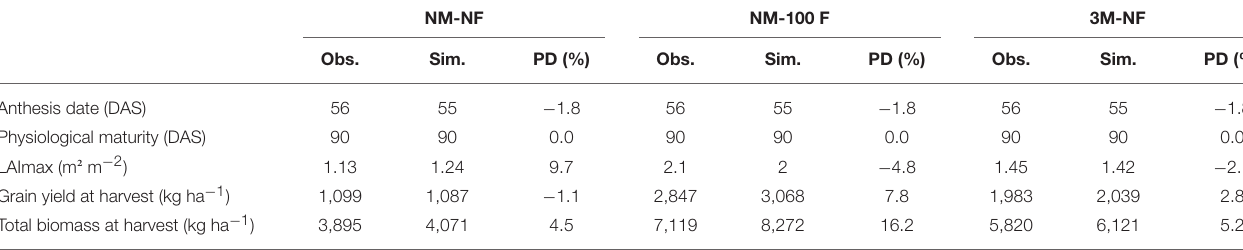
TABLE 2 | Results of model calibration for the 3 selected treatments in 2014. NM-NF NM-100 F 3M-NF Obs. Sim. PD (%) Obs. Sim. Obs.